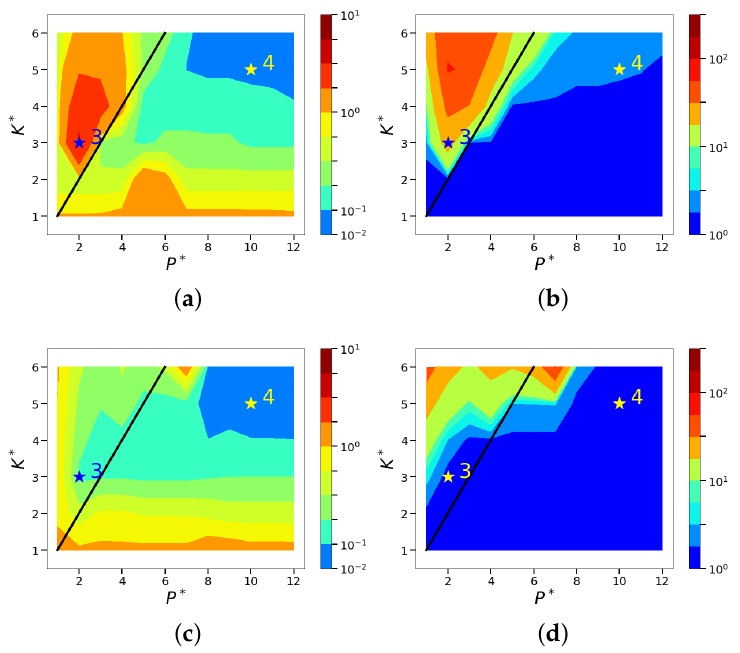
Figure 8. Isocontours of the normalized mean squared POD-based sparse reconstruction errors ( l 2 norm) using different random seed (108 and 109) for sensor placements. Left: normalized absolute error metric, (cid:101) 1 . Right: normalized relative error metric, (cid:101) 2 . ( a ) (cid:101) 1 (seed = 108); ( b ) (cid:101) 2 (seed = 108); ( c ) (cid:101) 1 (seed = 109); and ( d ) (cid:101) 2 (seed =